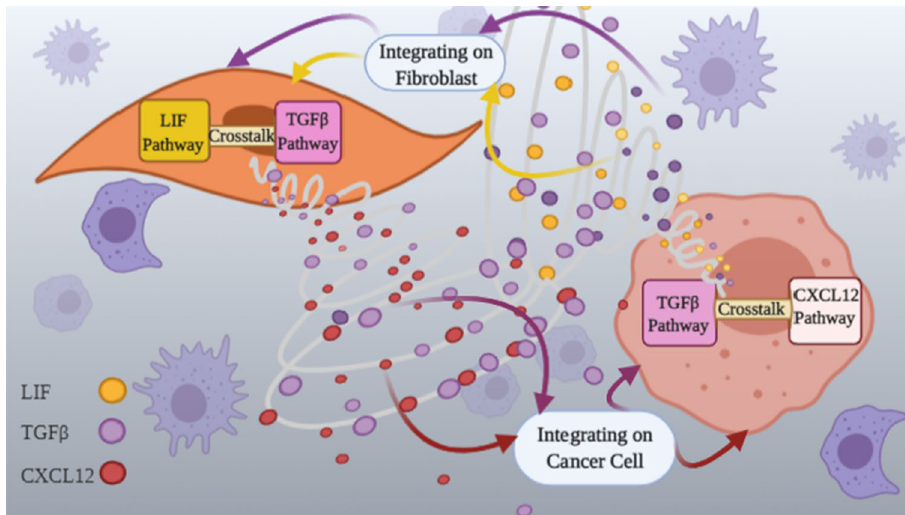
Figure 4. Intercellular interactions between CAFs and cancer cells in the TME. TGFβ, LIF and, CXCL12 pathways are responsible for the release of communicating signals in the TME. TGFβ and LIF molecules are circulating from cancer cells to CAFs, as well as CXCL12 and TGFβ from CAFs to cancer